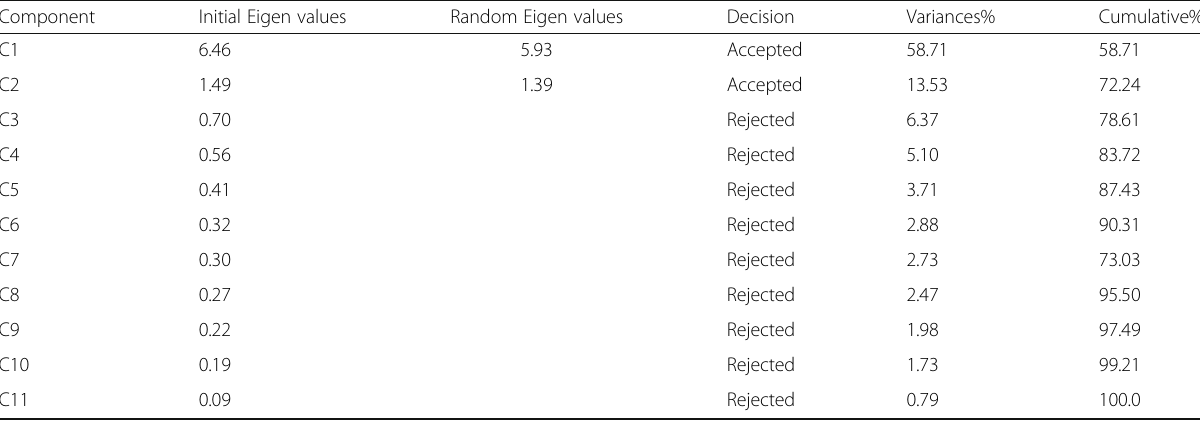
Table 5 Principal Component analysis and Monte Carlo PCA for parallel analysis of the I-RNLI